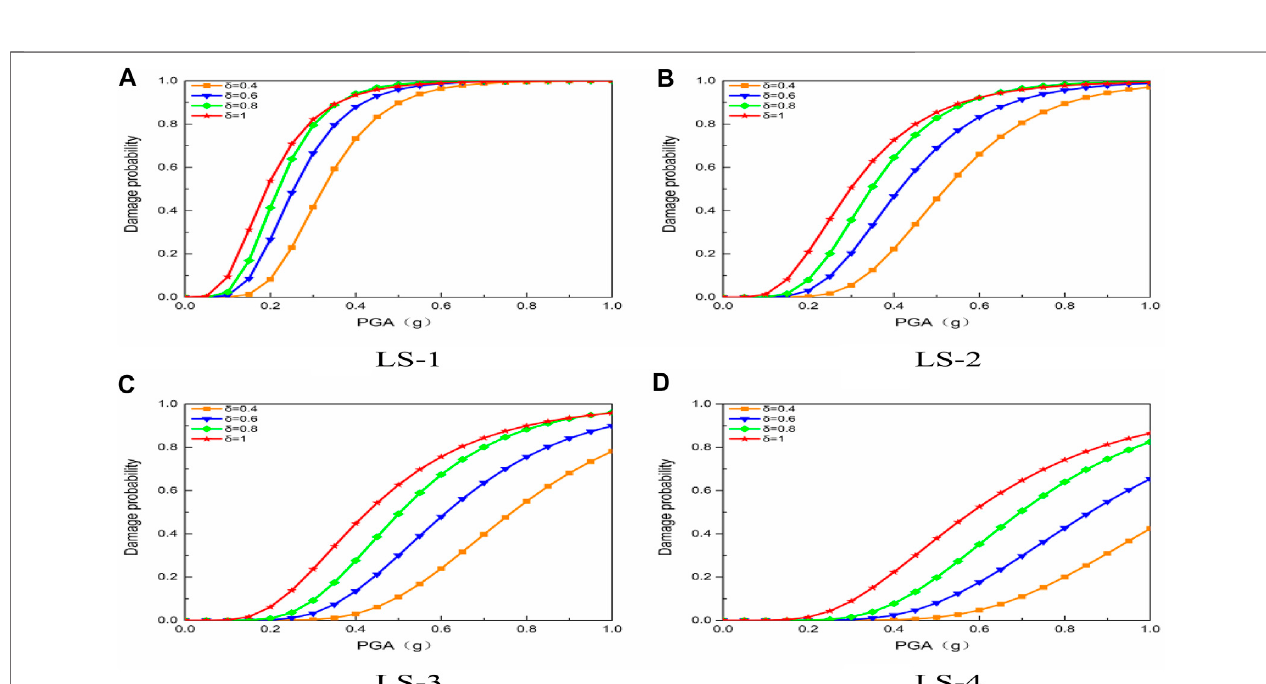
FIGURE 15 | The fragility curves of the mainshock-damaged URM model under aftershock. (A) LS-1 (B) LS-2 (C) LS-3 (D) LS-4.